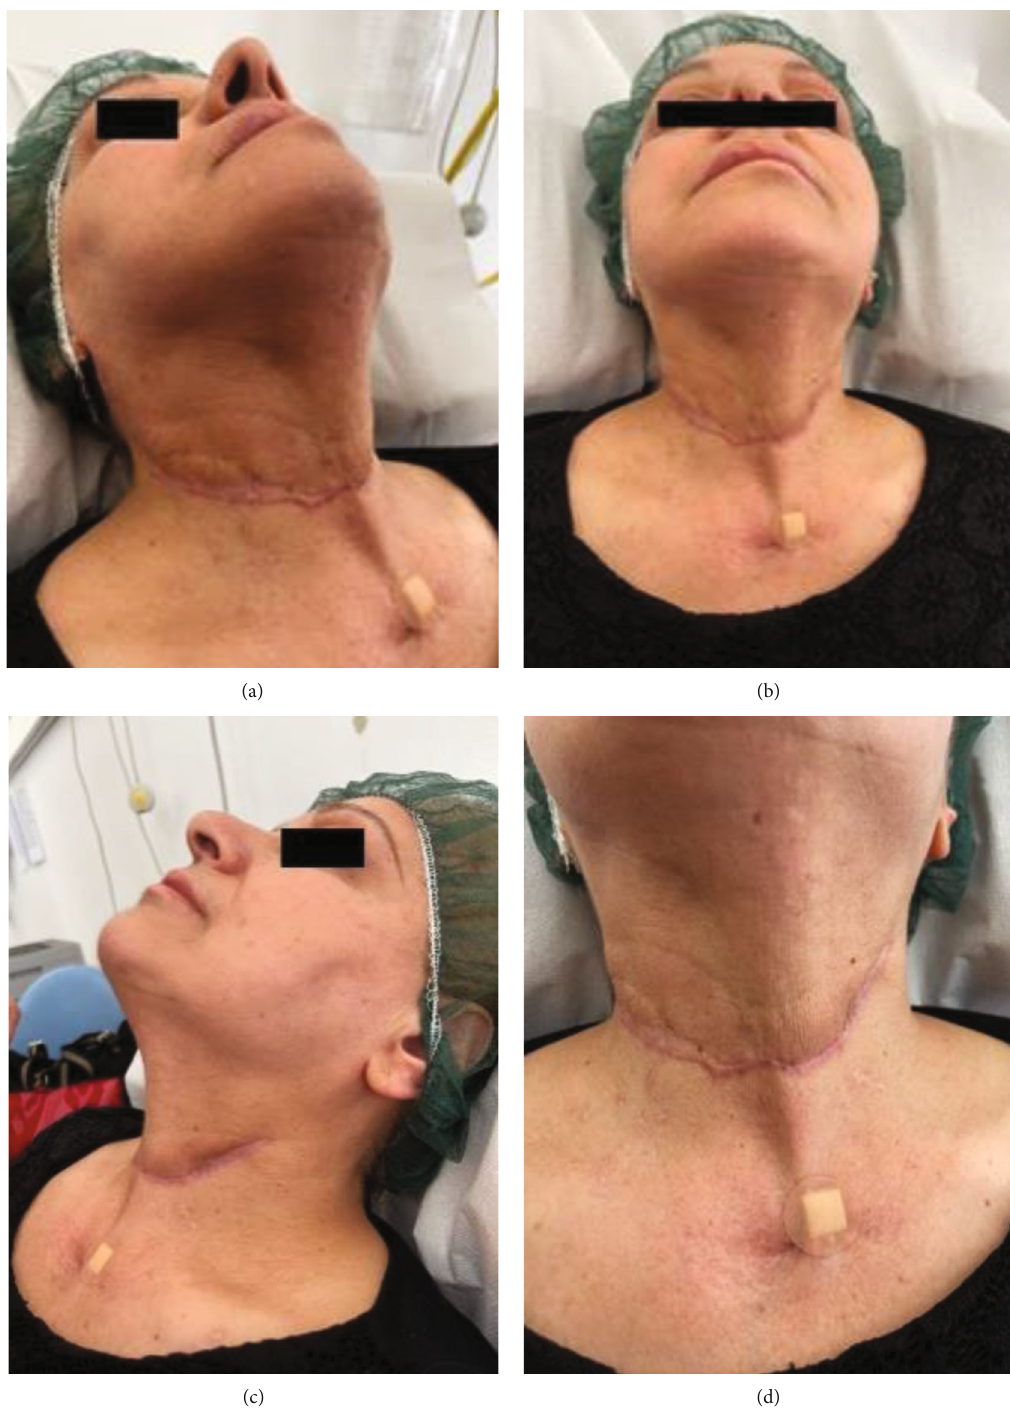
Figure 9: (a – d) Final patient photos: right side (a); front (b); left side (c); neck scar detail (d). Presence of scarring outcomes on the neck; absence of swelling of the face and